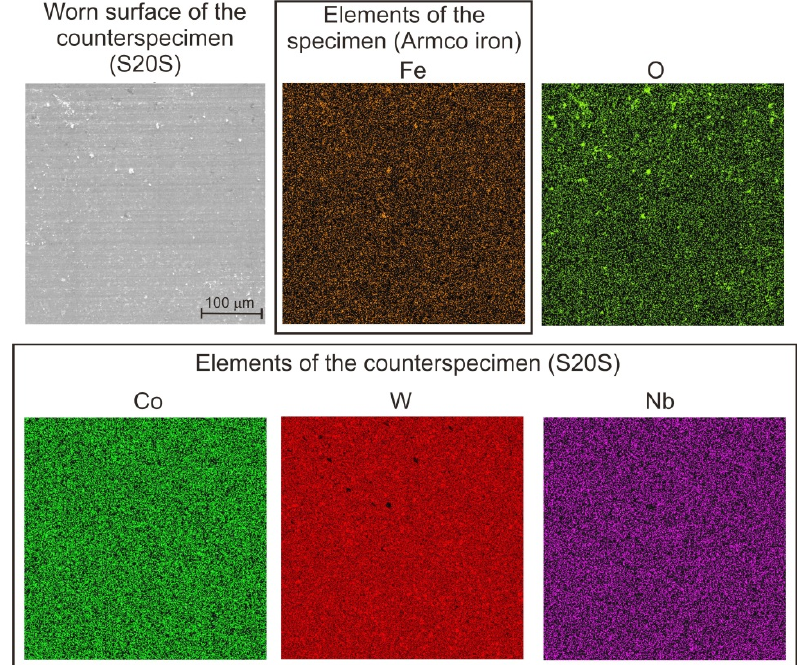
Figure 9. The worn surface and EDS pattern of counter-specimen (S20S) after wear test of untreated Armco iron.